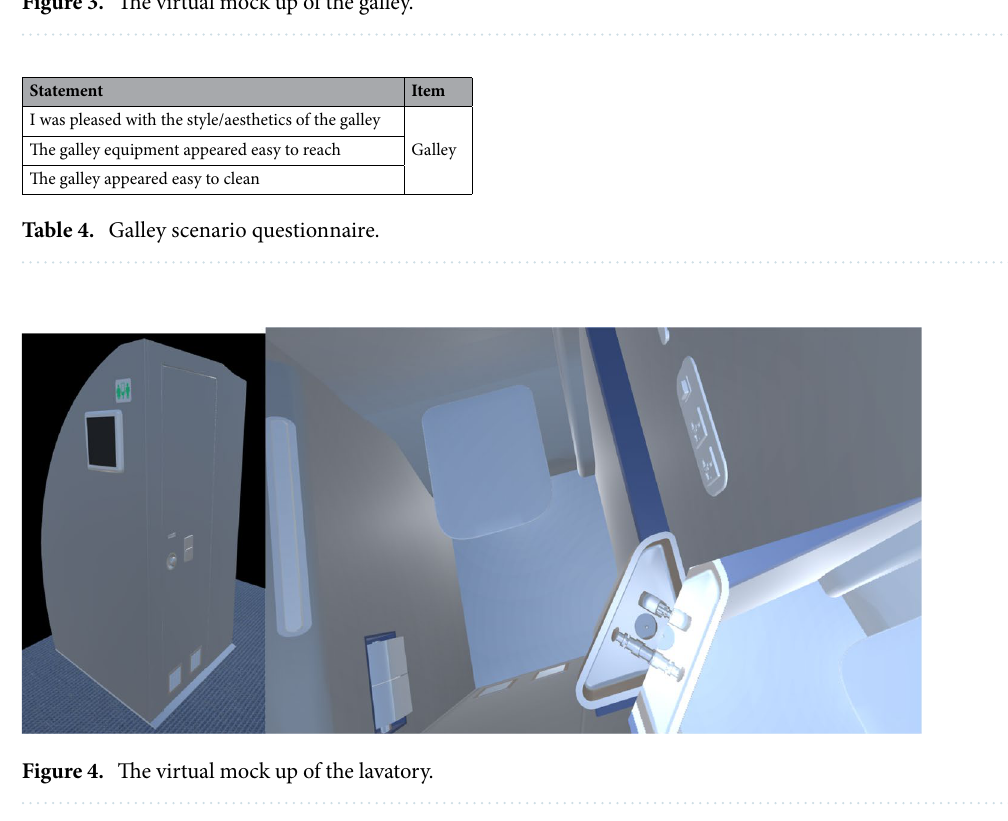
Figure 3. The virtual mock up of the galley.